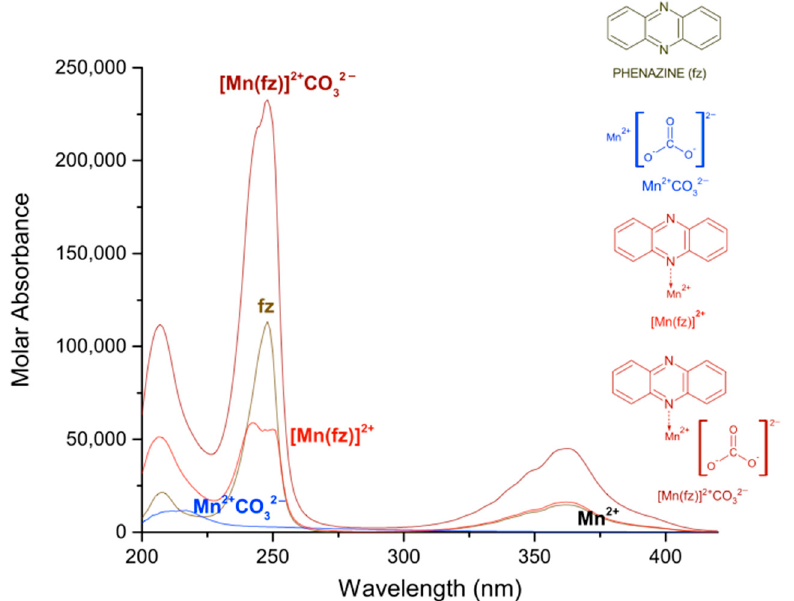
[Mn(fz)] 2+ , Mn 2+ CO 2 − Figure 7. Calculated electronic spectrum of manganese(II)–phenazine–carbonate in methanol: Mn 2+ ,